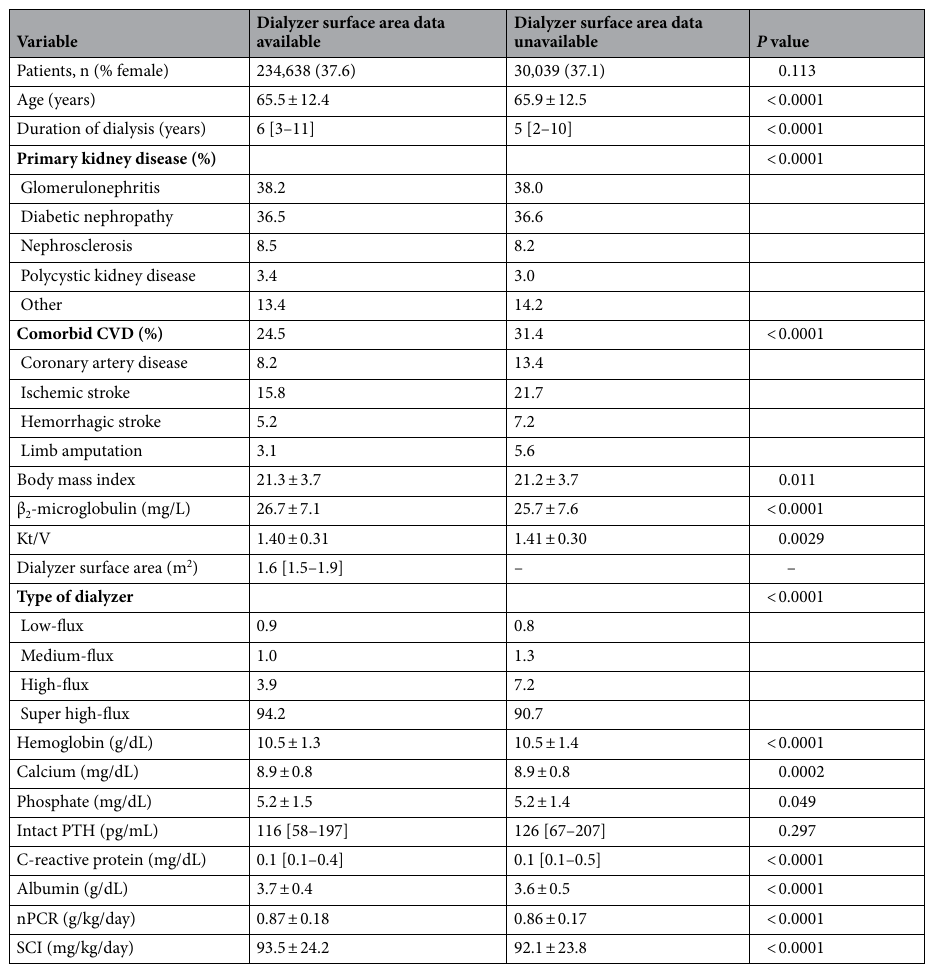
Table 1. Demographics, clinical characteristics, and laboratory findings in a 3-year cohort of 264,677 patients on hemodialysis, including 234,638 patients with data on dialyzer surface area. Data are expressed as mean ± standard deviation (SD), number (%), or median [interquartile range]. CVD cardiovascular disease, nPCR normalized protein catabolic rate, PTH parathyroid hormone, SCI simplified creatinine